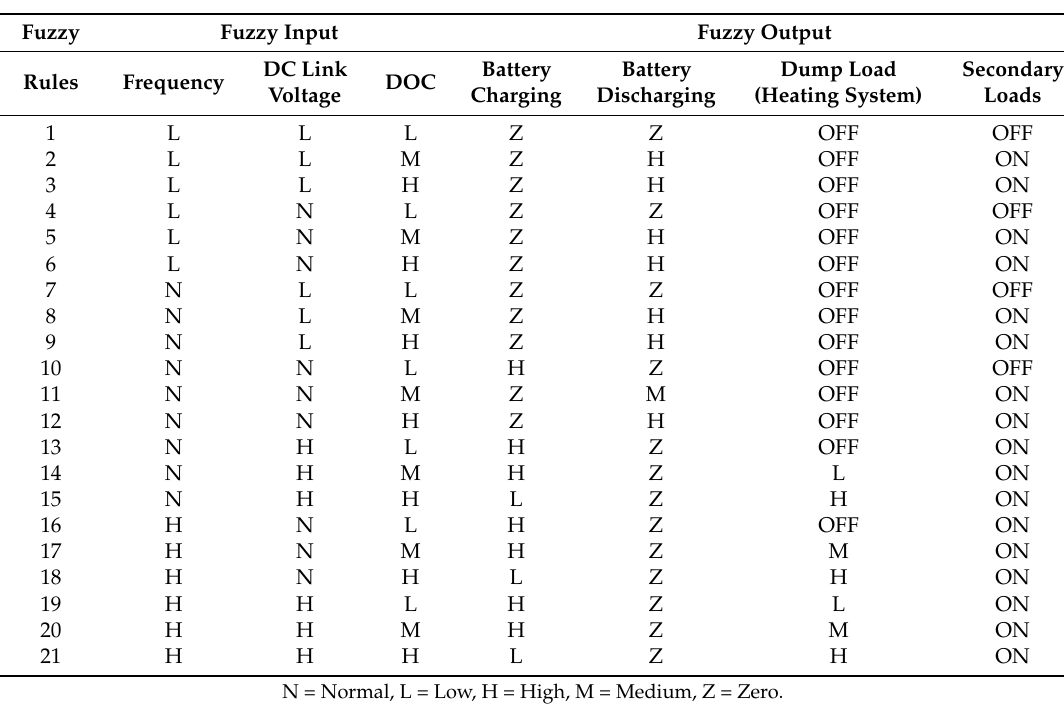
Table 2. Fuzzy logic rules.